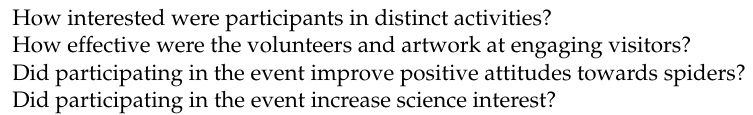
Table 1. Overview of focal study questions associated with Eight-Legged Encounters